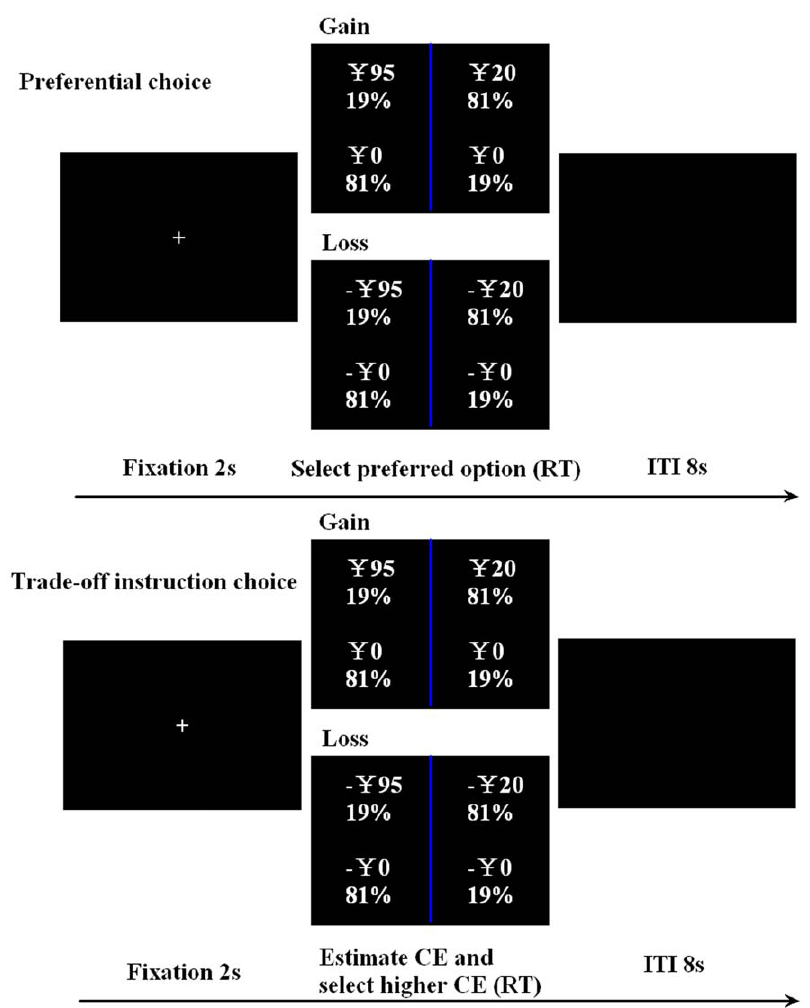
Figure 1. Experimental design. CE denotes certainty equivalence.